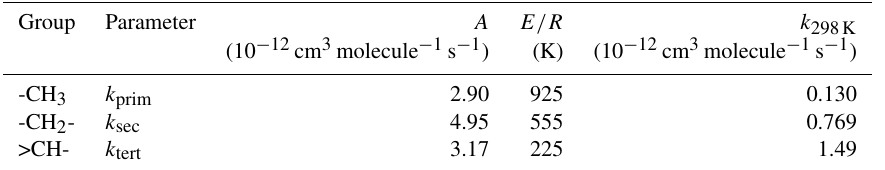
Table 1. Arrhenius parameters ( k = A exp ( − (E/R)/T ) ) for the group rate coefficients for H-atom abstraction from -CH 3 , -CH 2 - and - CH< groups; and the group rate coefficient values at 298K.